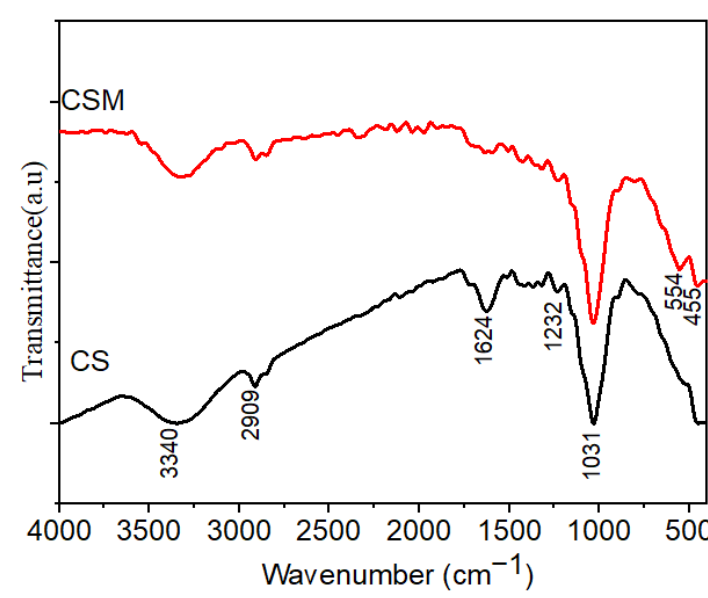
Figure 4. TGA curve of CS and CSM.